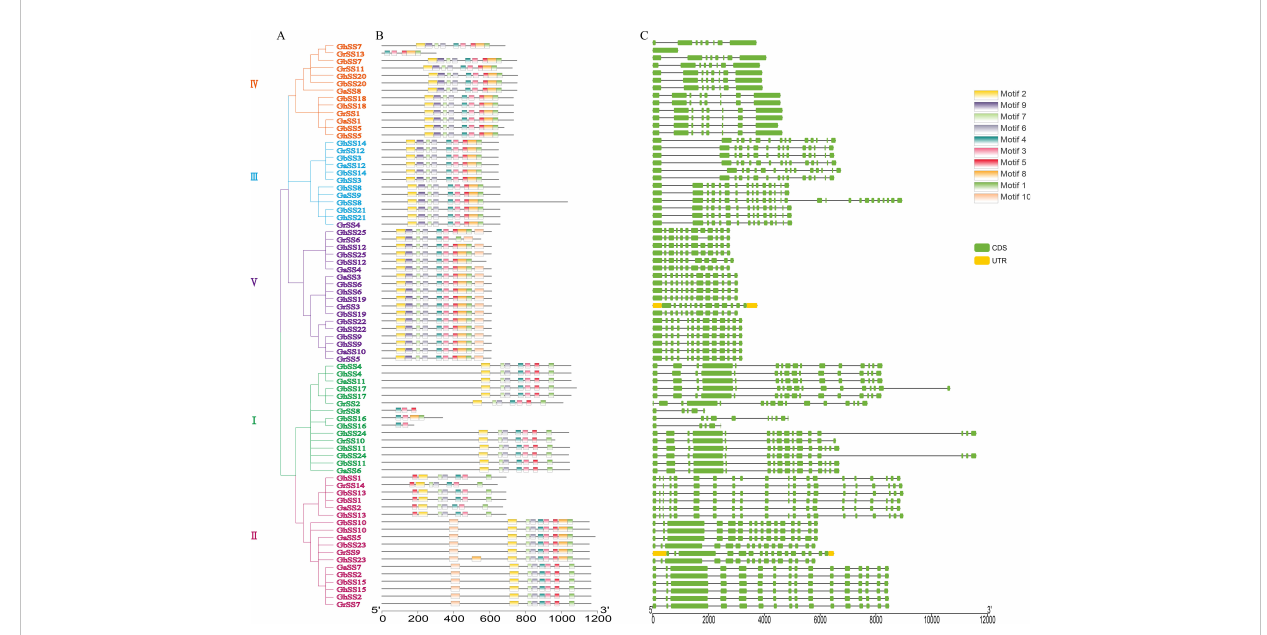
FIGURE 2 Conserved motifs and exon-intron structure of SS genes in G arboreum , G raimondii , G hirsutum , and G barbadense . (A) Phylogenetic tree of SS genes. (B) Conserved motifs of SS proteins. (C) The exon – intron structure of SS